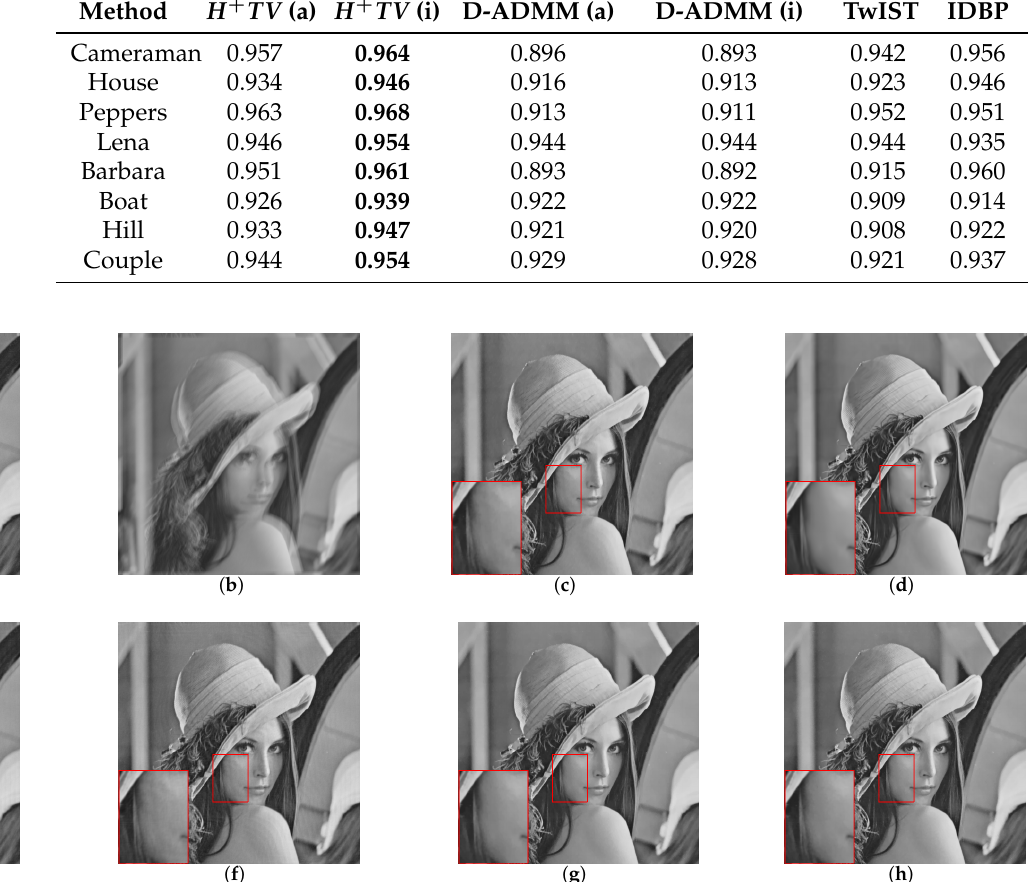
Figure 2. Recovered results results of image ( d ) obtained using different algorithms. ( a ) Original. ( b ) Degraded. ( c ) TwIST. ( d ) IDBP. ( e ) D-ADMM (a). ( f ) D-ADMM (i). ( g ) H + TV (a). ( h ) H + TV